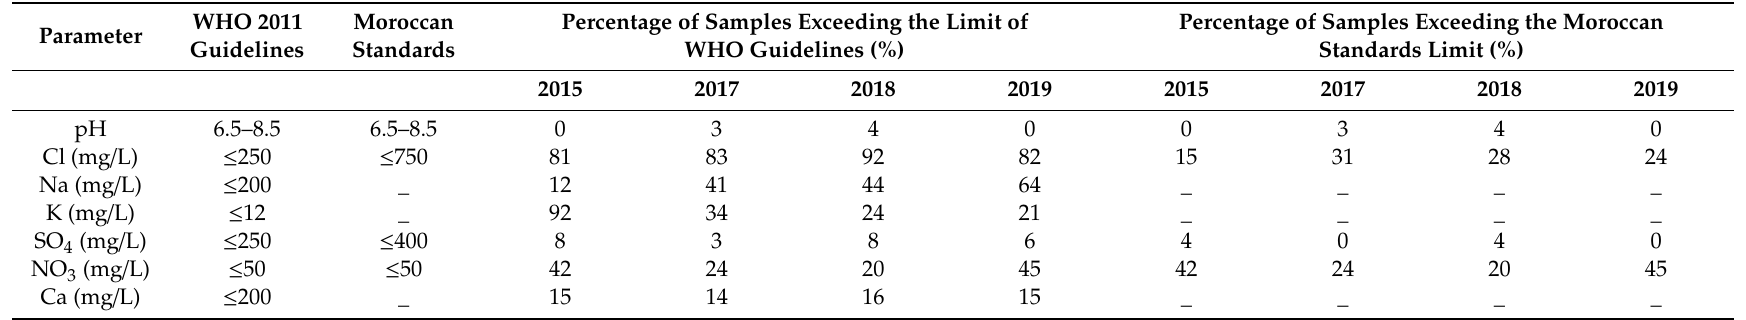
Table 3. Water parameters comparison with World Health Organization (WHO) and Moroccan